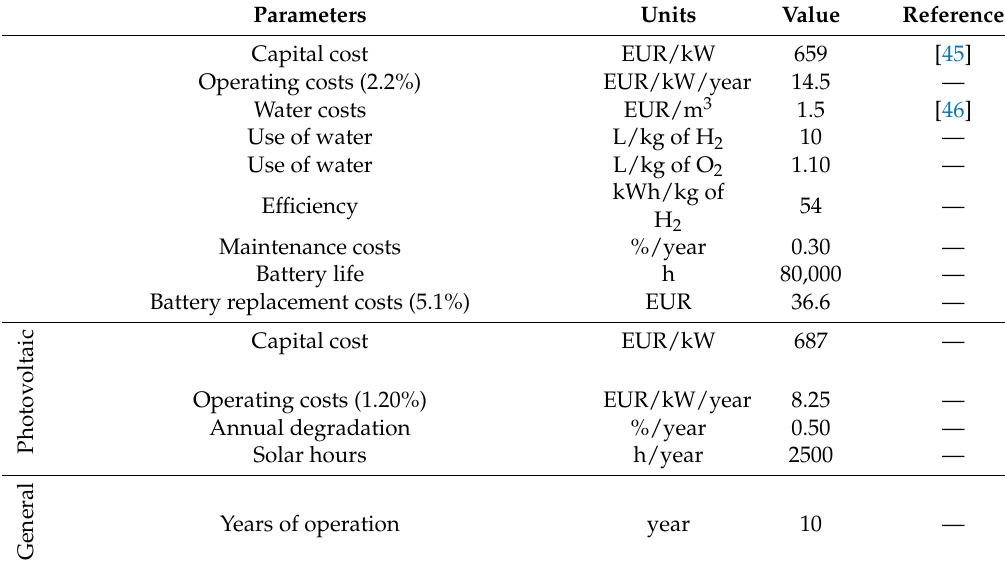
Table 3. Initial assumptions for the electrolysis unit (hydrogen and oxygen production).